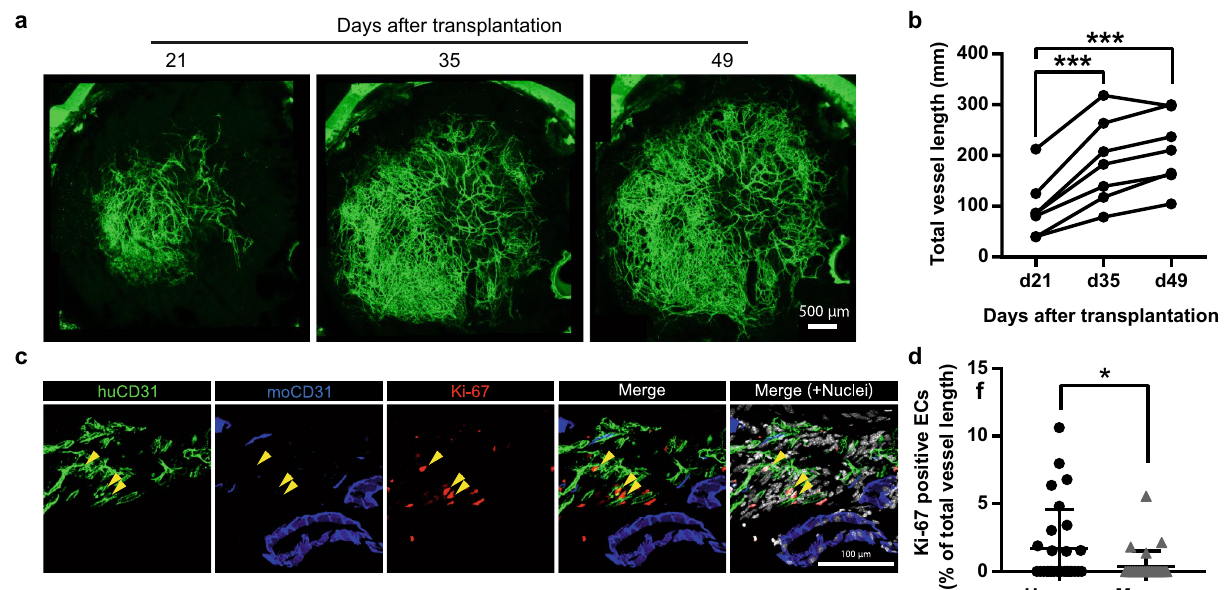
Figure 4. Continuous observation of tumor-derived human blood vessels ( a ) Representative images of continuously expanding human blood vessels derived from patient #1 in the cranial window. ( b ) Quantification of total human blood vessel length in the cranial window. Data for each value were evaluated statistically (n = 7). One-way ANOVA and Dunnett’s multiple comparisons testing was used to compare day 21 and day 35, day 21 and day 49. ( c , d ) Ki-67-positive ECs in patient tumor dura mater at day 50 after tumor transplantation. ( c ) Immunofluorescence staining of human ECs (huCD31, green), cell division marker (Ki-67, red), mouse ECs (moCD31, blue). Hoechst staining shows total nuclei (gray). Yellow arrowheads show Ki-67-positive human ECs. ( d ) Quantification of Ki-67-positive human ECs and mouse ECs. Data mean ± SD. (n = 6). Welc’s t test was used to compare with Ki67 positive human ECs between that of mouse. *p < 0.05. ***p <